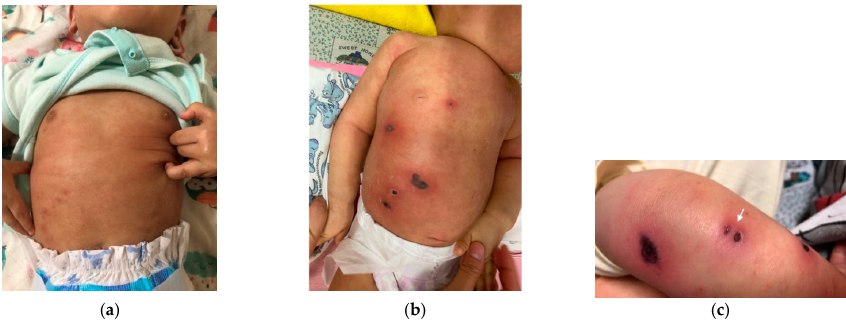
Figure 1. The initial presentation of the skin lesions revealed erythematous papules over the excoriated skin of chest and abdomen ( a ); the erythematous papules progressed to necrotic eschar with surrounding erythema ( b ); more progressive papulonodular lesions with necrosis (white arrow) were observed on limb skin ( c ).